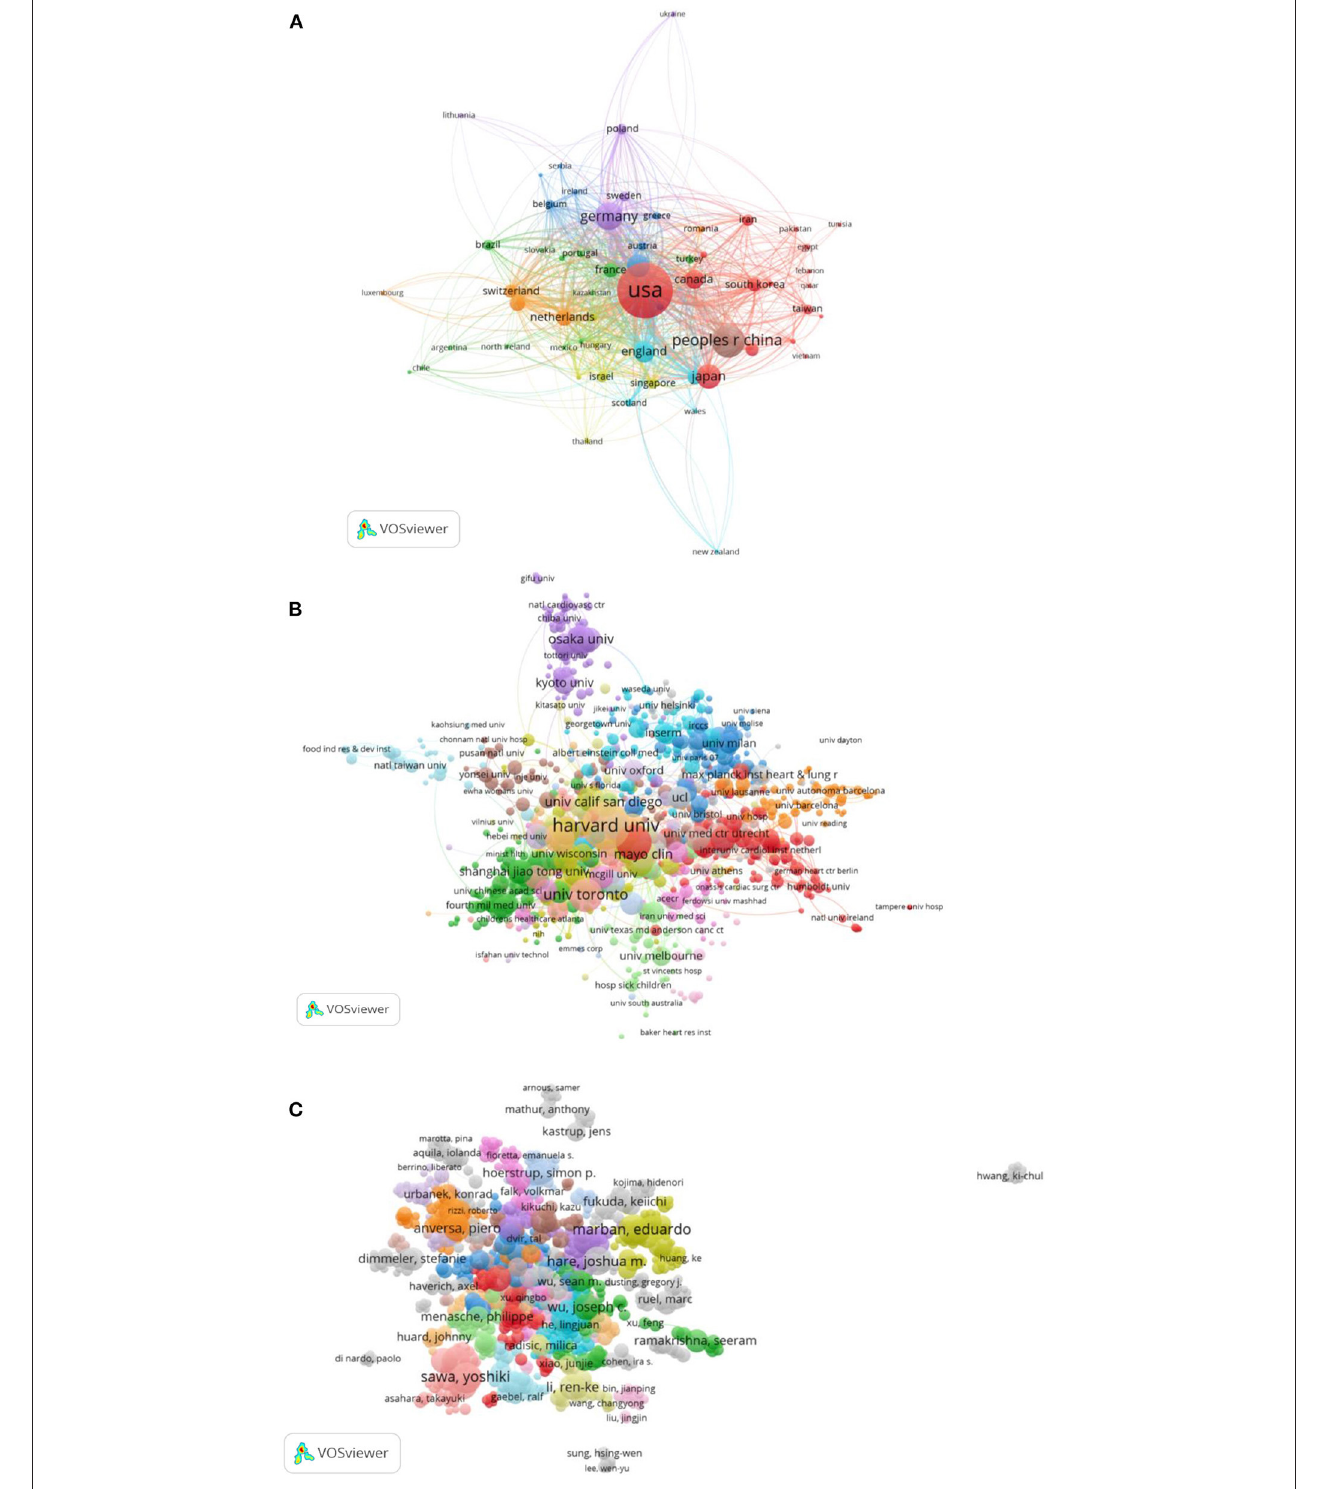
FIGURE 2 | The collaboration analysis of countries/regions, institutions, and scholars in the field of cardiac regeneration. (A) The collaboration network of countries/regions. Eight cooperation clusters with different colors were formed with a total link strength of 5,866. (B) The collaboration network of institutions. Twenty-one cooperation clusters with different colors were formed with a total link strength of 17,147. (C) The collaboration network of scholars. Thirty-one clusters with different colors were formed with a total link strength of 21,621.